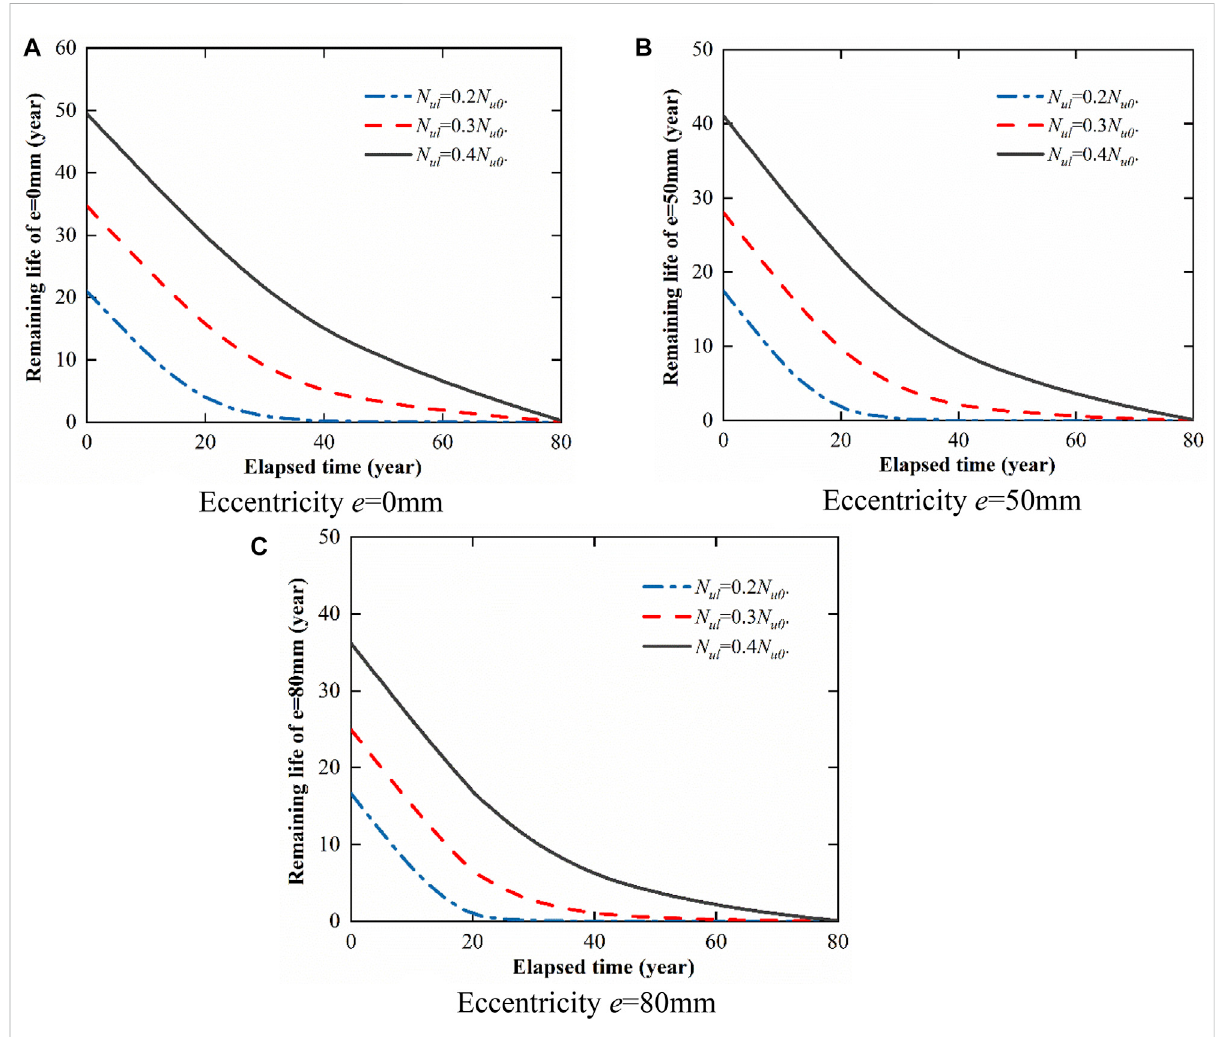
FIGURE 13 Estimated remaining life of the corroding columns under different loading conditions for various allowable deterioration limits N ul